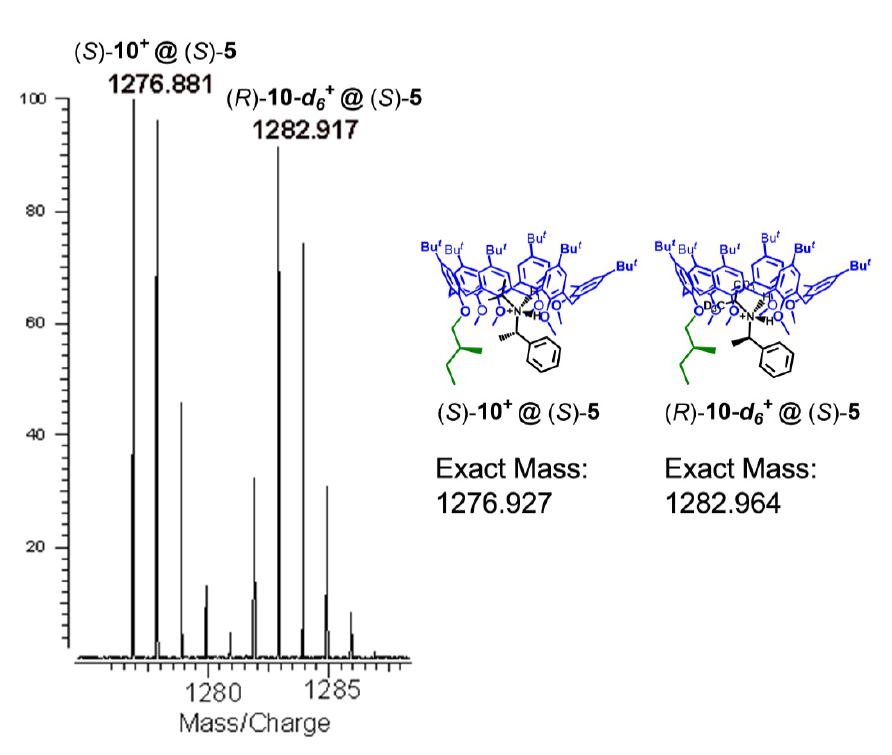
Figure 10. Significant portion of the mass spectrum of a 1:2:2 mixture (CH 2 Cl 2 , 300 µ M) of derivatives ( S )- 5 , ( S )- 10 + · [B(Ar F ) 4 ] − , and ( R )- 10 - d 6 + · [B(Ar F ) 4 ] − .